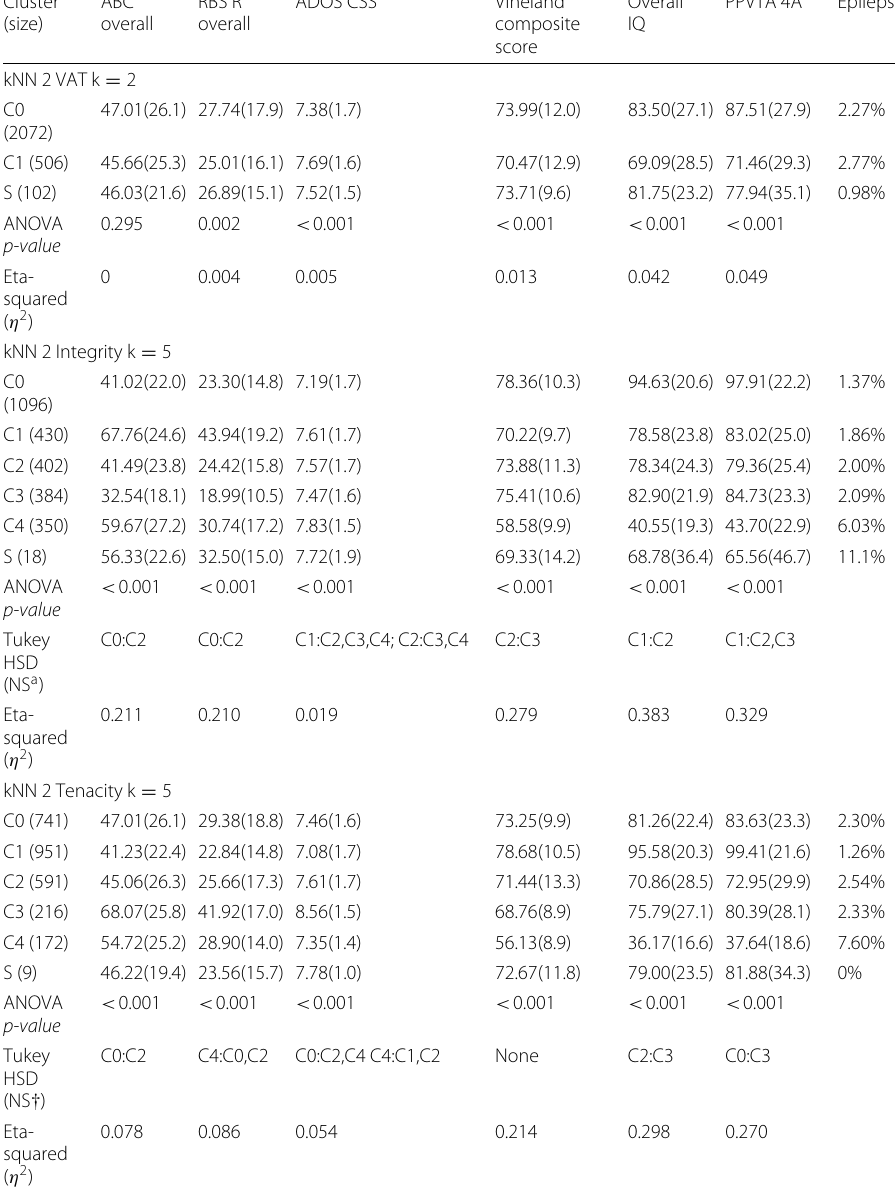
Table 7 Statistical analysis of optimal clustering configurations using selected ASD outcome measures: for kNN2 graphs without node